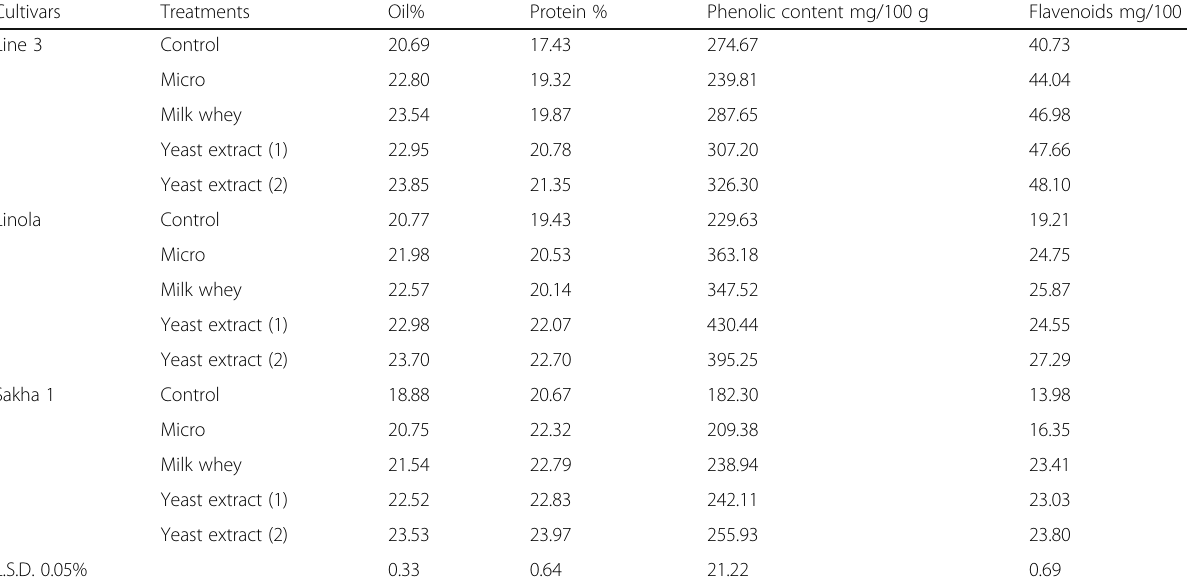
Table 10 Effect of interaction between flax cultivars and bio-fertilizer treatments on nutritive value of the yielded seeds